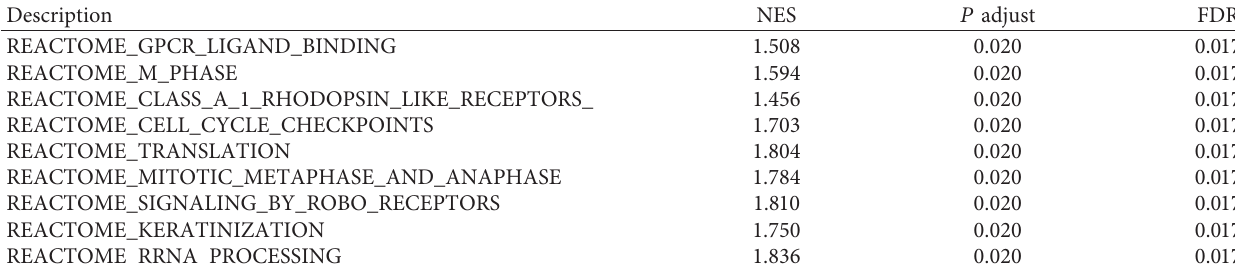
Table 5: Gene sets enriched in of ELF3-AS1 high and low expression groups in HCC